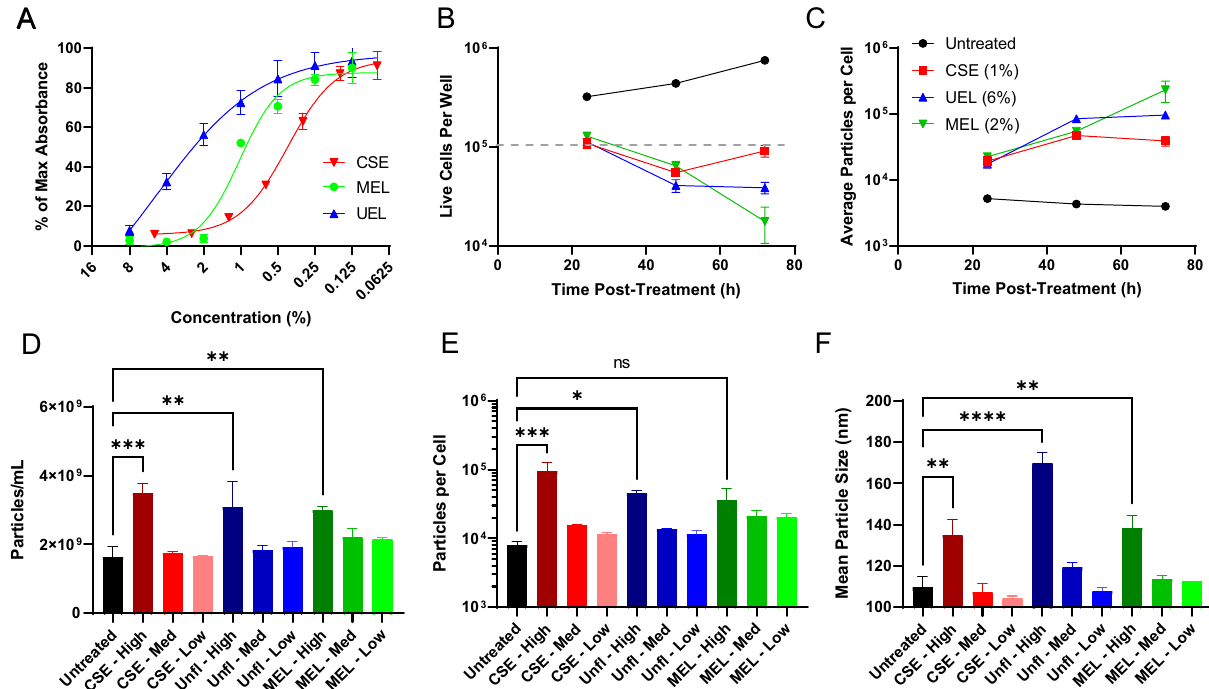
Figure 1. Cigarette smoke and E-liquid exposure enhance EV release from BC cells. ( A ) TCCSUP cells in 96-well plates were treated with a range of concentrations of CSE, UEL, or MEL for 24 h. An MTT assay was then used to detect cell viability. ( B,C ) TCCSUP cells in 12-well plates were treated for 24, 48, or 72 h with CSE (1%), UEL (6%), or MEL (2%). The number of live cells per well was then counted ( B ), with the gray dashed line corresponding to the number of initially plated cells. The number of EVs released per cell was further determined through a nanoparticle tracking analysis of supernatants released by these cells ( C ). ( D–F ) TCCSUP cells were treated for 24 h with low, intermediate (Med), or high concentrations of CSE, UEL, or MEL corresponding to the IC20, IC50, and IC80 concentrations of these stimulants identified in ( A ). The numbers of EVs released and the size of these EVs was then analyzed via a nanoparticle tracking analysis. CSE, cigarette smoke extract; UEL, unflavored E-liquid; MEL, methol E-liquid. Samples were analyzed in duplicate, and all results are representative of a minimum of three experiments. Data are means ± SEM. *P < 0.05, **P < 0.01, ***P < 0.001, ****P < 0.0001; one-way ANOVAs with Tukey’s post hoc